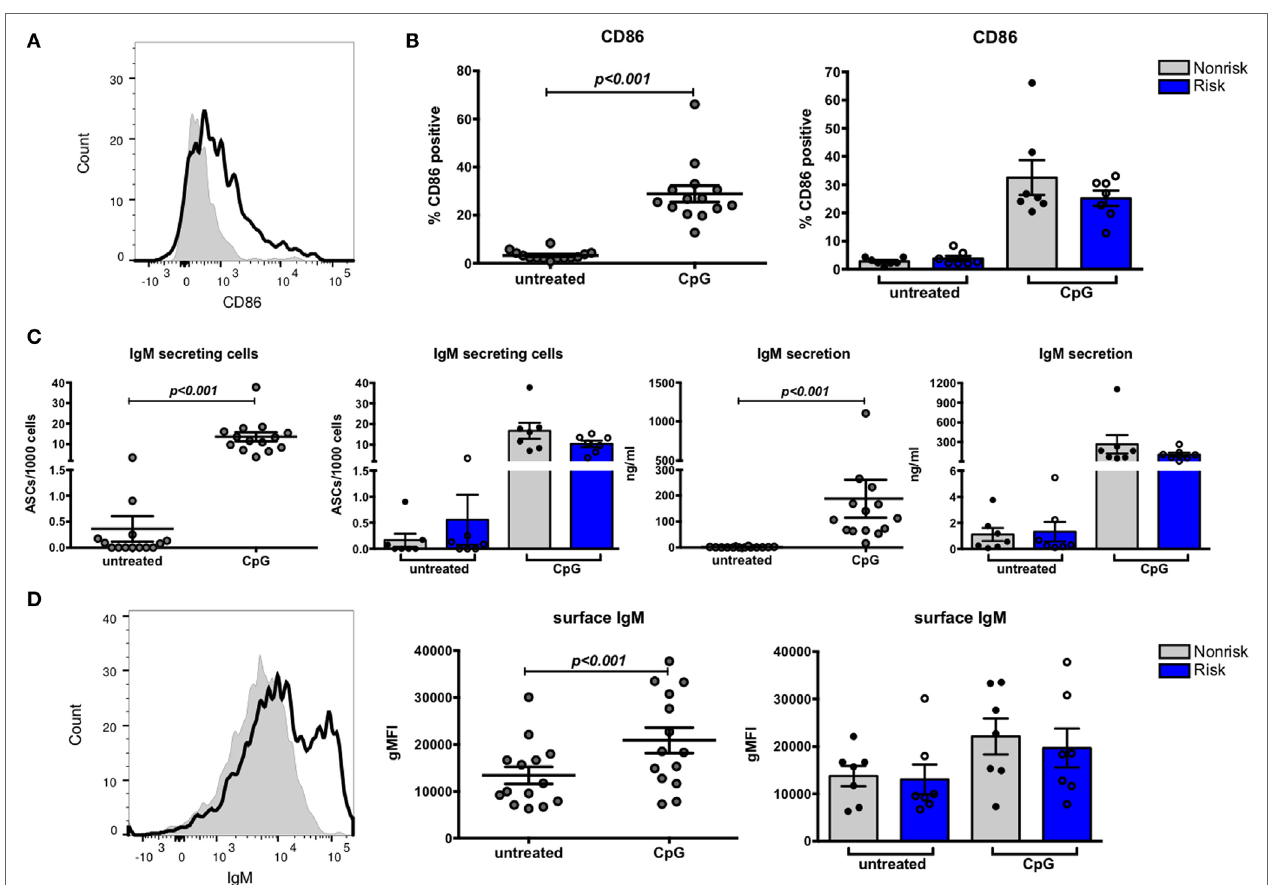
FigUre 5 | B cell stimulation results in upregulated CD86 expression and antibody-secreting cell (ASC) differentiation. Naive B cells were cultured for 4 days with or without CpG and analyzed by flow cytometry. (a) Representative histogram of CD86 expression on untreated (shaded peak) and CpG-treated (black outlined peak) B cells. (B) CD86 expression on B cells combined (left) and separated by haplotype (right). (c) ELISpot data showing proportion of ASCs combined (far left) and separated by haplotype (center left) and ELISA data showing IgM secretion by B cells combined (center right) and separated by haplotype (far right). (D) Representative histogram of surface IgM expressed on untreated (shaded peak) and CpG-treated (black outlined peak) B cells. Flow cytometric results of IgM expression on B cells combined (center) and separated by haplotype (right). p < 0.001 by Wilcoxon matched-pairs signed rank test [ (B) , left; (c) , far left and center right; (D) , center], p = ns by Mann–Whitney test for each treatment [ (B) , right; (c) , center left and far right; (D) , right].